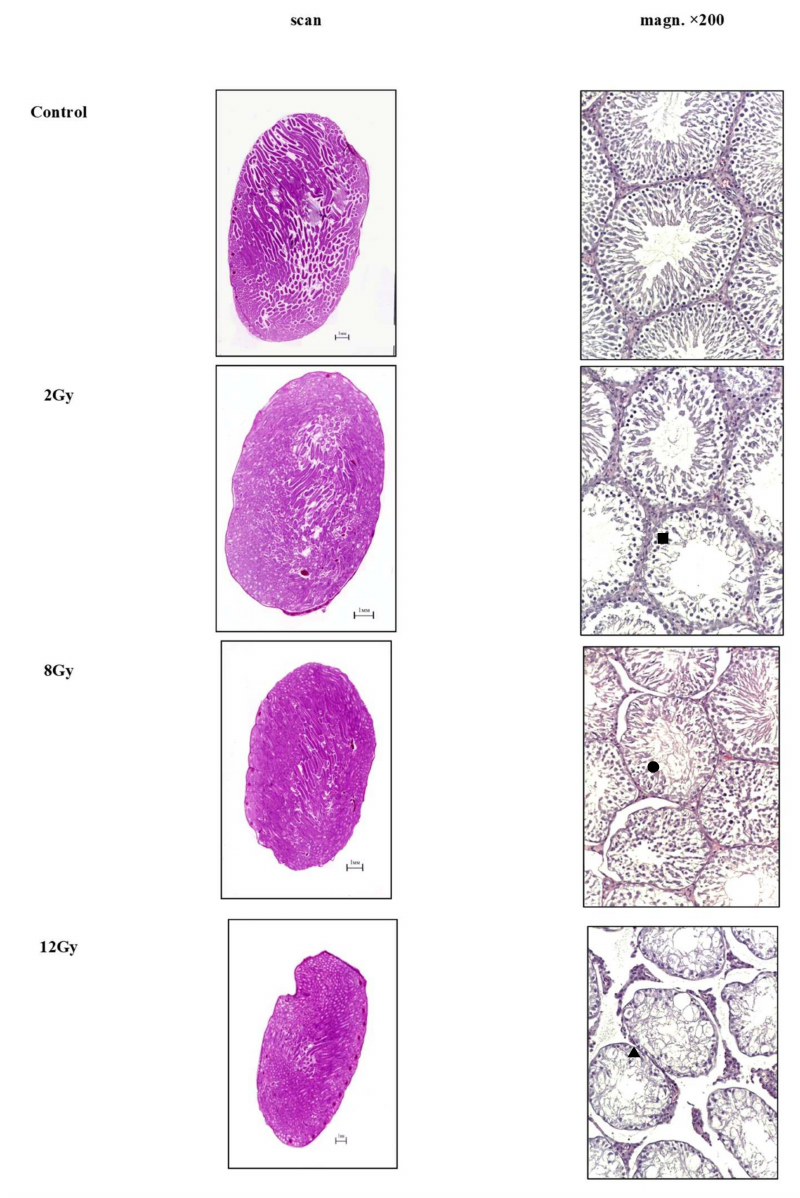
Figure 1. Testes of rats of experimental groups at different radiation doses; stain—hematoxylin and eosin, magn. × 200 ( (cid:4) —the proportion of damaged seminiferous tubules (area—28,079.84 µ m 2 ; diameter—189.083 µ m; p < 0.01) with disorganization of the epithelium and loss of cell polarity accounted for up to 1/8 of the testis (1–2 transverse sections of tubules in sight); • —1/3 of the seminiferous tubules showed the appearance of highly degenerated spermatids and spermatocytes combined into seminal balls (area—0.7 µ m 2 ; diameter—0.9 µ m; p < 0.01). The area of single primary spermatocytes was 0.8 µ m 2 at p < 0.01, and the diameter was 0.9 µ m at p < 0.01, which is 1.1 times more than normal; (cid:78) —the largest vacuoles were found in the seminiferous tubules of the irradiation group with a dose of 12 Gy. The number of seminal balls doubled, and their size was 5.0–10.0 times larger than the area of the primary spermatocyte. The dimensions of the aplastic seminiferous tubules are significantly smaller (area—14,123.72 µ m 2 ; diameter—76.142 µ m; height of the spermatogenic epithelium—14.2 ± 12.1 at p < 0.01; an increase in the number of pathological mitoses) than in the previous groups, and therefore, an increase in the interstitial component was observed testes with edema. Damage to the seminiferous tubules was